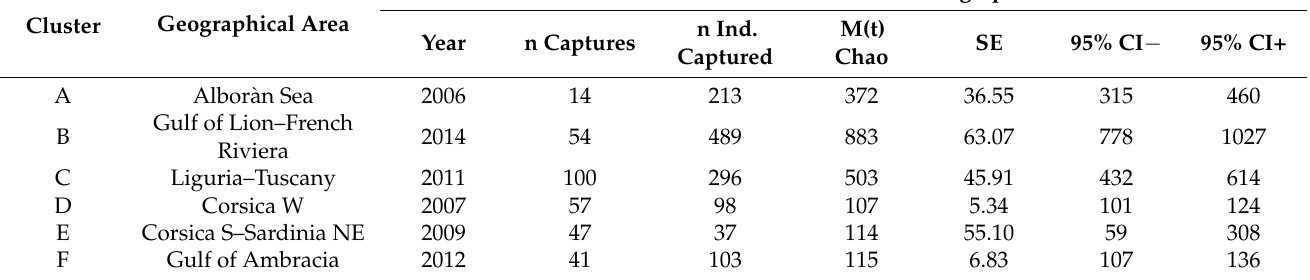
Table 7. The abundance (best annual estimate, see Section 2.3.6.) of the clusters/geographical units, estimated with the mark–recapture technique.